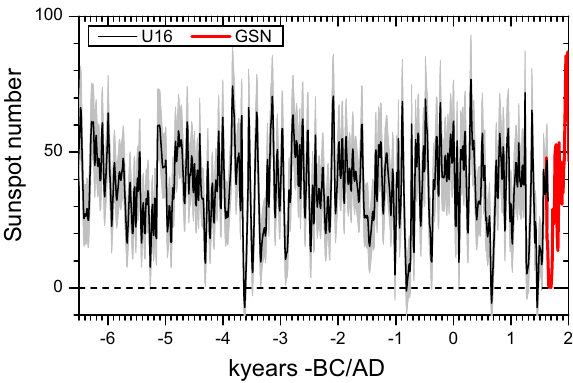
Fig. 18 Long-term sunspot-number reconstruction from 14 C data with error bars (after Usoskin et al. 2016a). Group sunspot numbers (Hoyt and Schatten 1998) are shown after